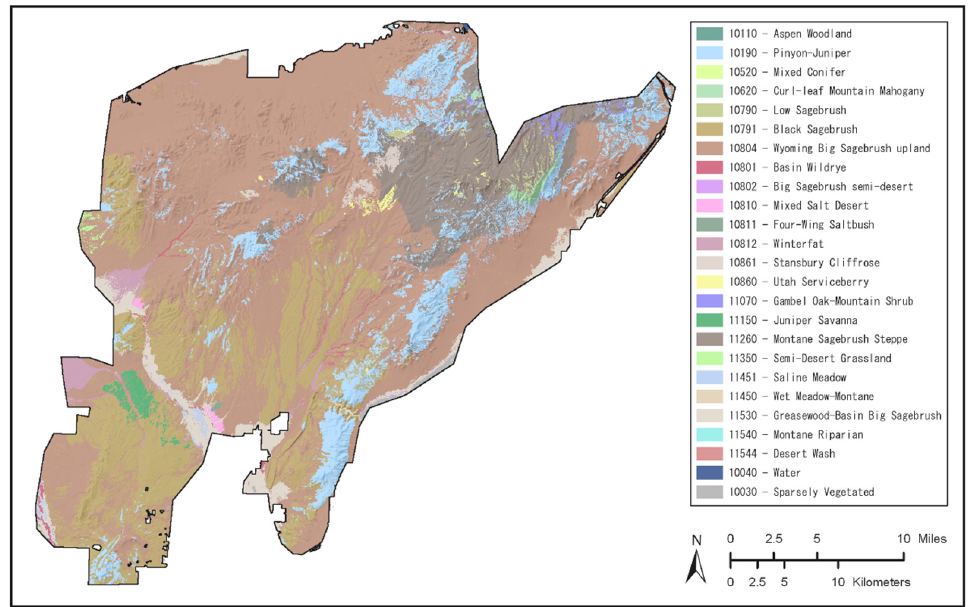
Figure 4. Ecological systems of the Black Mountains. Mapping was based on interpreted multispectral RapidEye 5 m resolution satellite imagery from 19 June 2013.